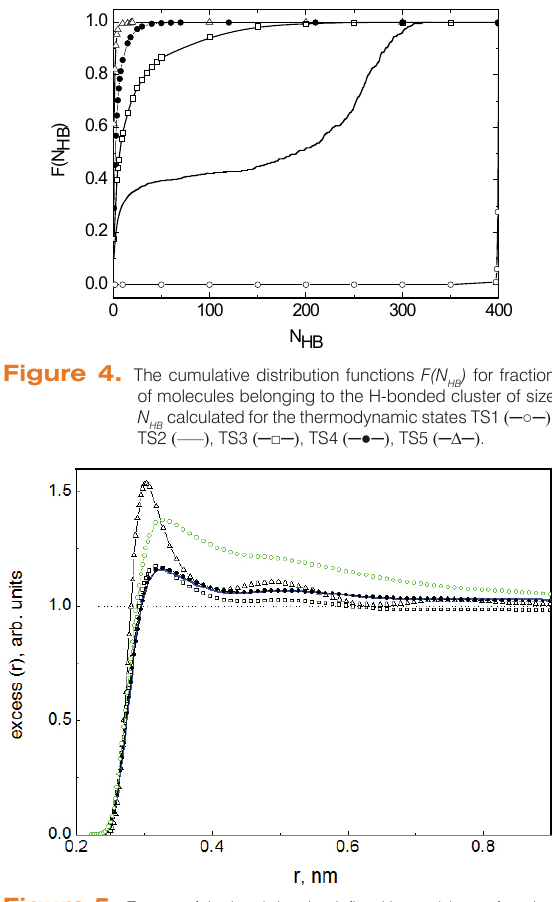
Figure 5. Excess of the local density defined in eq. (5) as a function of distance r from a central molecule: TS1 (─∆─) ,